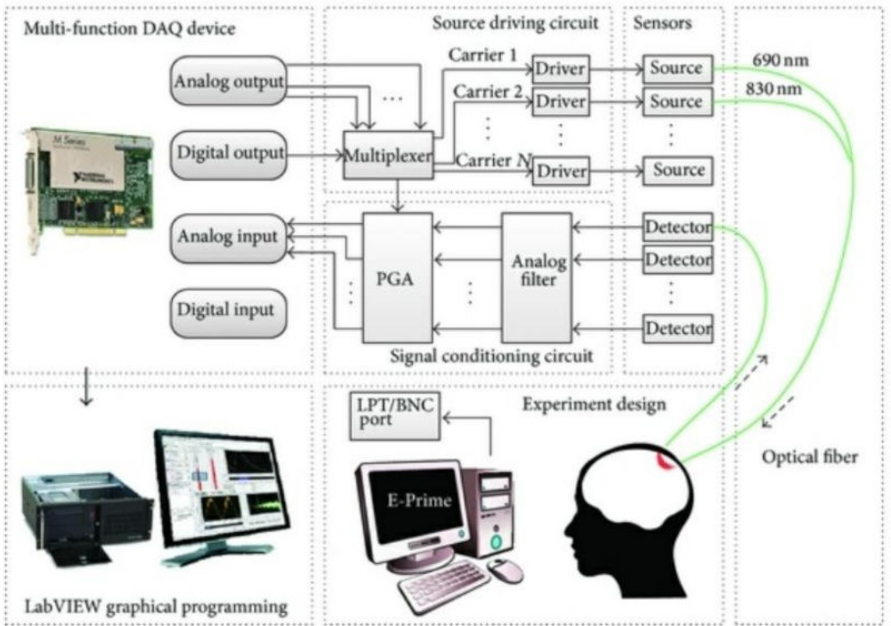
Figure 7. An example of a combined continuous wave and fNIRS brain–computer interface system. (Reprinted from